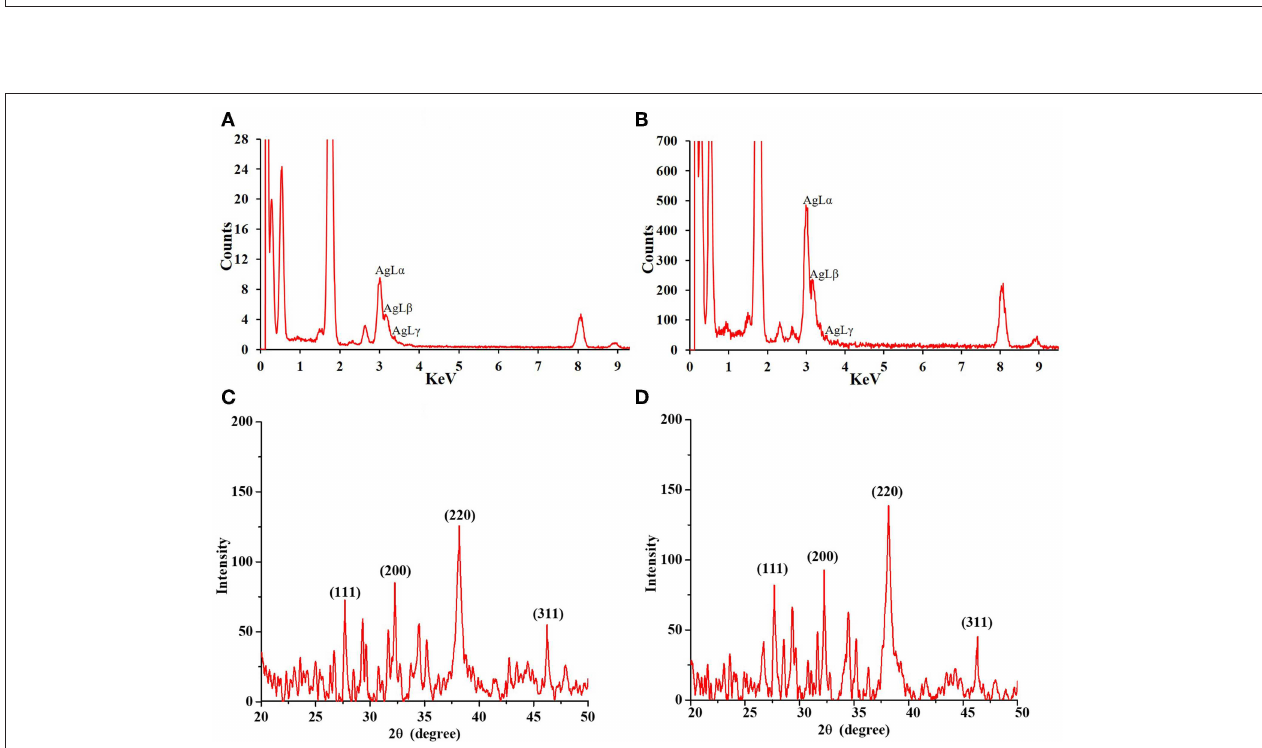
FIGURE 3 | Energy dispersive X-ray (EDS) spectra of Aq-bAgNPs (A) , and Et-bAgNPs (B) . Peaks at ∼ 3 keV indicate the presence of Ag in the biogenic nanoparticles. Powder XRD analysis of as-synthesized Aq-bAgNPs (C) , and Et-bAgNPs (D) .